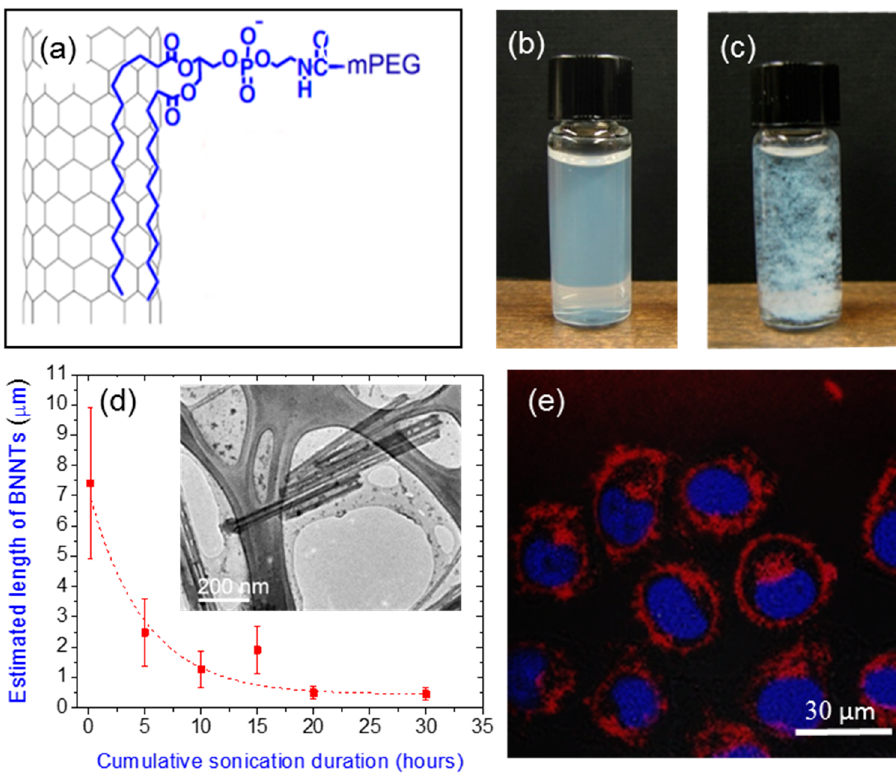
Figure 4. ( a ) Schematic of BNNTs functionalized with m-PEG-DSPE molecules in water. ( b ) Appearance of well-dispersed BNNTs functionalized with mPEG-DSPE molecules in water. These suspension is very stable versus unfunctionalized BNNTs suspended in ethanol ( c ); ( d ) The lengths of the functionalized BNNTs as a function of sonication/cutting duration. TEM images of cut BNNTs are shown in the inset. Adapted with permission from [52]. Copyright 2010 American Chemical Society; ( e ) Overlay of fluorescence images of HeLa cells (nuclei stained in blue) incubated with functionalized BNNTs (in red).